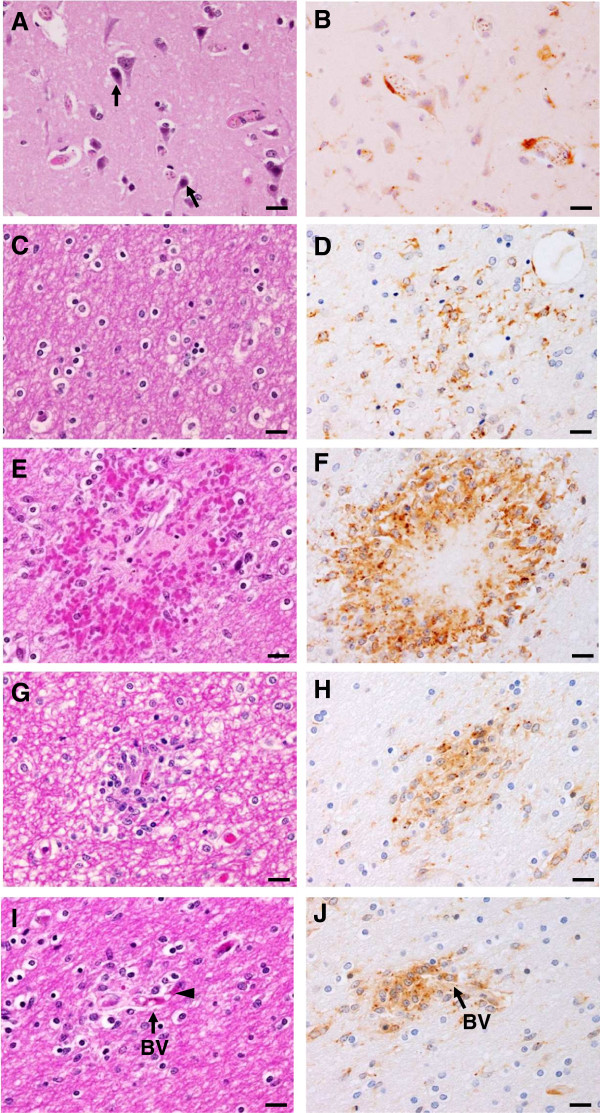
Histopathologic changes (A, C, E, G, I) and pattern of immunohistochemistry staining for NF-κB p65 (B, D, F, H, J) in the brain of fatal cerebral malaria. (A) Group of neurons (H&E). Apoptotic features of cellular shrinkage, apoptotic nuclei and increased cytoplasmic staining for eosin were observed in some neurons (arrows). (B) Neurons demonstrating predominantly cytoplasmic NF-κB p65 staining. (C) Glial cells in white matter (H&E). (D) Group of glial cells showing cytoplasmic and nuclear NF-κB p65 immunostaining (E) Ring haemorrhage in white matter (H&E). (F) Glial cells in area of haemorrhage showed strong positive staining for cytoplasmic and nuclear NF-κB p65. (G) Mass of reactive glial cells forming an ill-defined granuloma collectively called Durck’s granuloma (H&E). (H) Reactive glial cells showed intense positive staining for cytoplasmic and nuclear NF-κB p65. (I) Group of glial cells associated with blood vessel (arrow) containing PRBCs (arrowhead) (H&E). (J) Glial cells stained for nuclear and cytoplasmic NF-κB p65 associated with blood vessel (arrow). Scale bars = 20 μm.